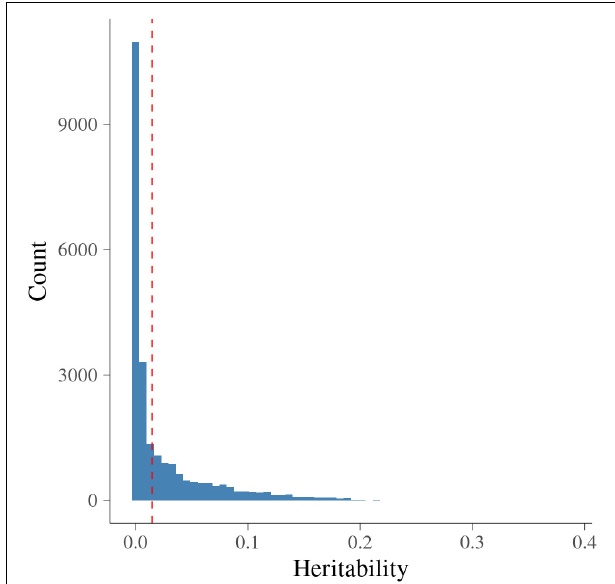
FIGURE 2 | Histogram of heritability for metabolomic features. x -axis is heritability from metabolomic features; vertical dashed red line is the significance level at 1% at each